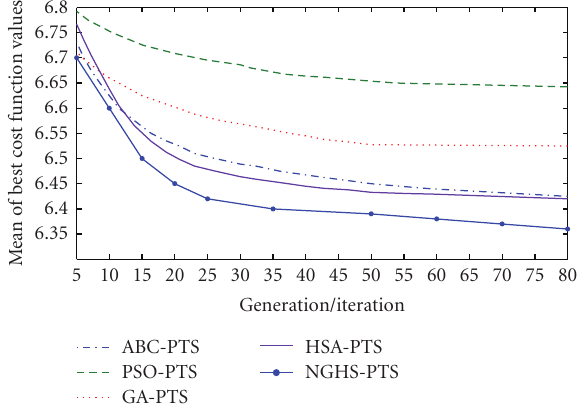
Figure 4: Mean of best cost function